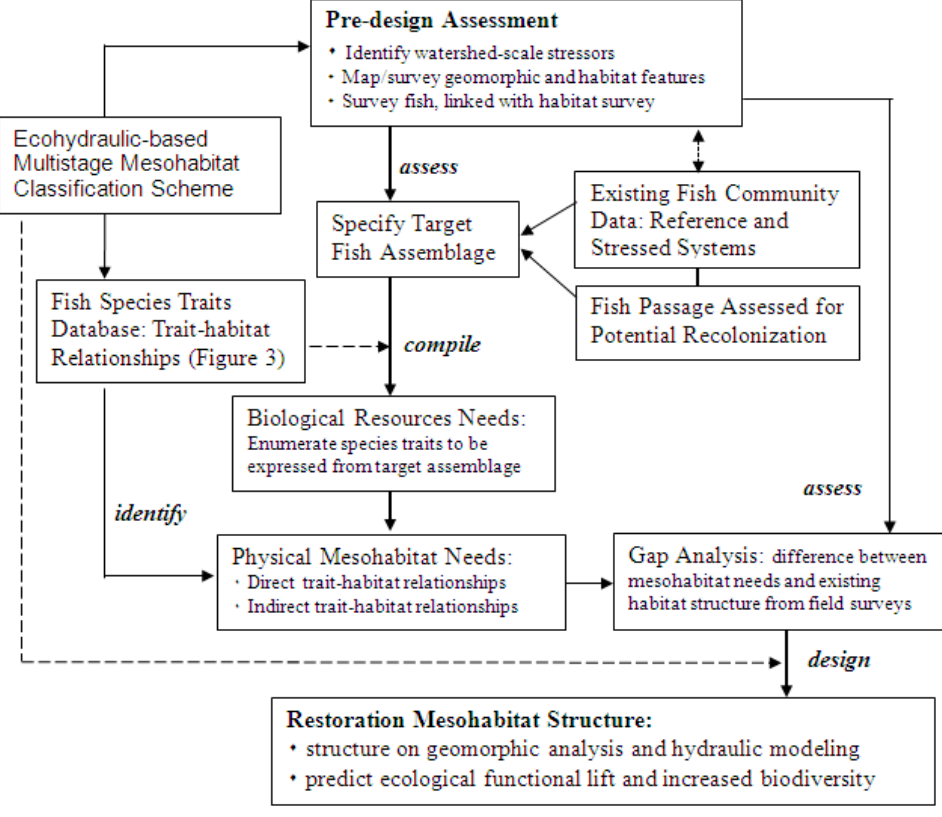
Figure 6. Proposed design protocols for multi ‐ stage ecohydraulic stream restoration using an ecoregion ‐ specific mesohabitat classification scheme and species functional traits.